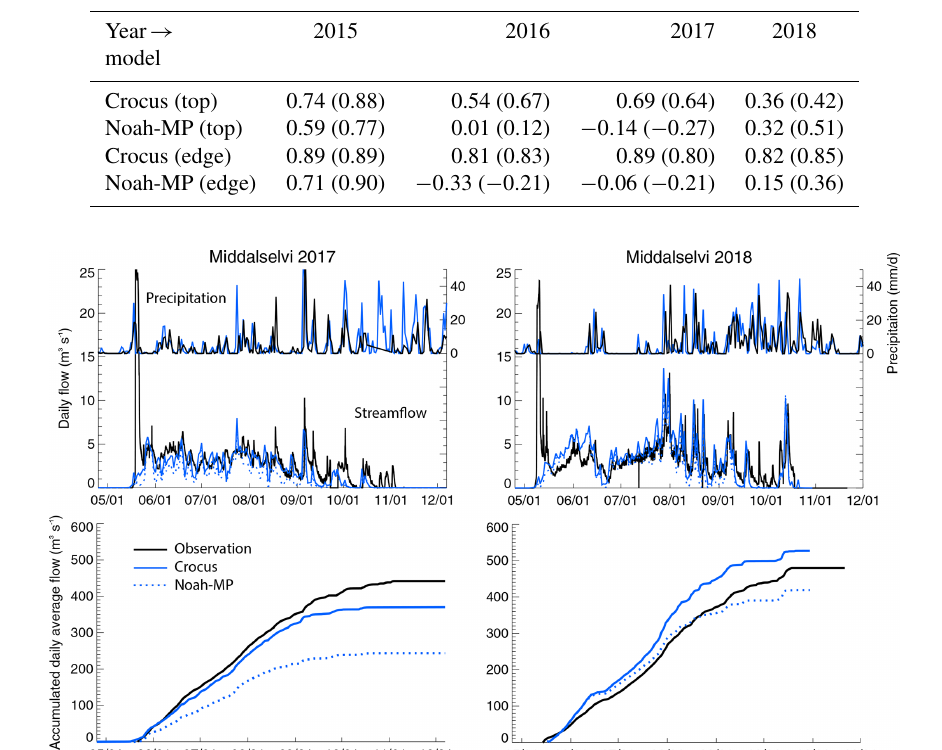
Table 2. Correlation coefficient between simulated and observed albedo. Values not in parenthesis are albedo from Modis Aqua, while values in parenthesis are albedo from Modis Terra.